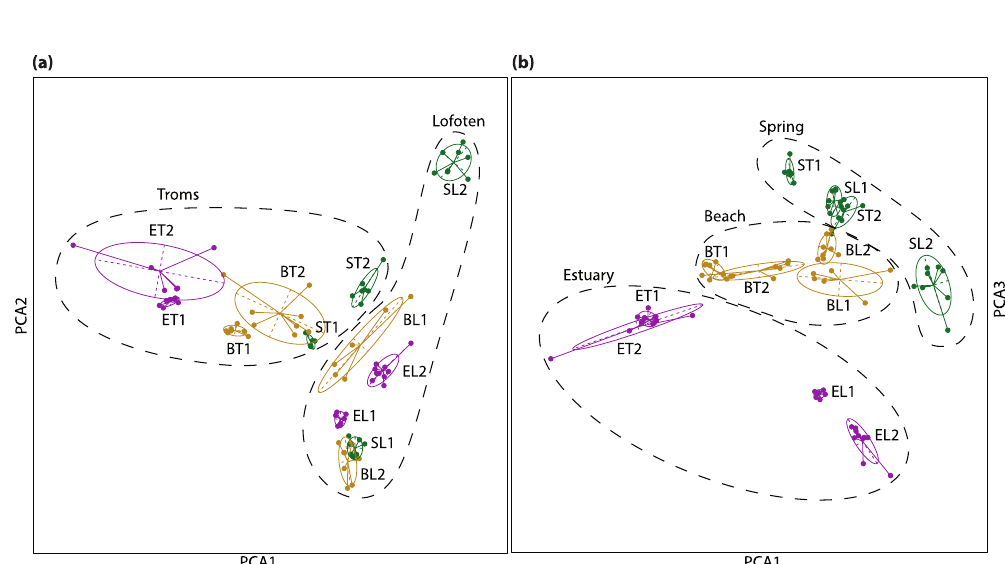
Figure 3. PCA performed on 12 populations of Cochlearia officinalis , using 4,296 SNPs from the RADseq data. ( a ) The first and second PCA axes. ( b ) The first and third PCA axes. The first PCA axis explains 4.05%, the second axis 3.82%, and the third axis 3.46% of the total variation. Colour represents ecotypes: estuary - purple, beach - yellow and spring - green. Individuals (dots) are linked to the centre of the 95% inertia ellipse for the population to which they belong. Populations are named according to ecotype (B = beach, E = estuary, S = spring) and geography (T = Troms, L = Lofoten), see Table